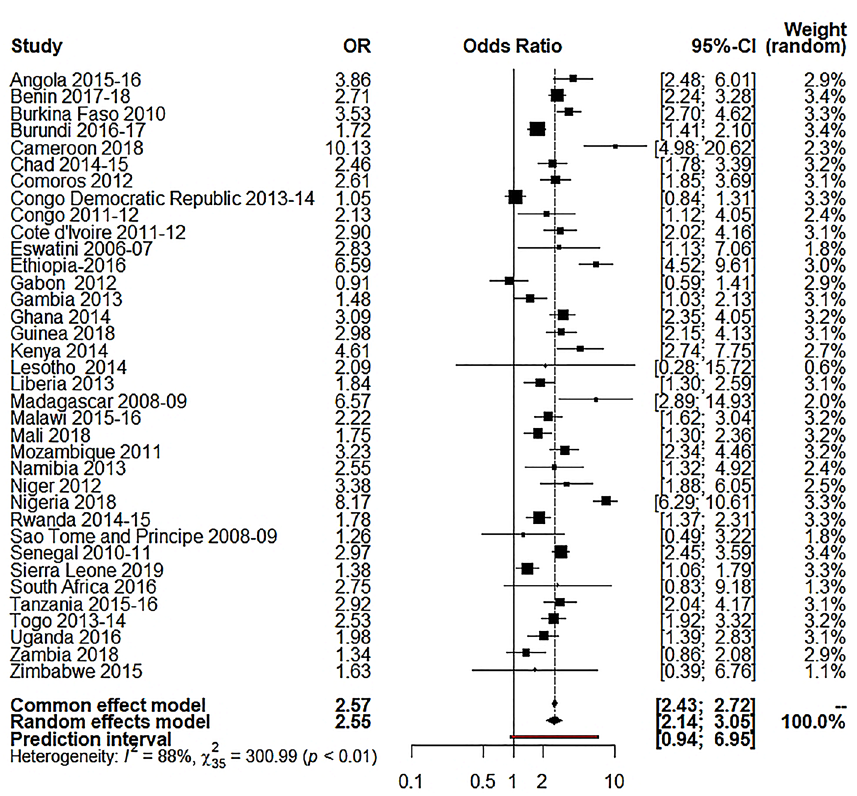
Figure 4. Forest plot for respondent’s